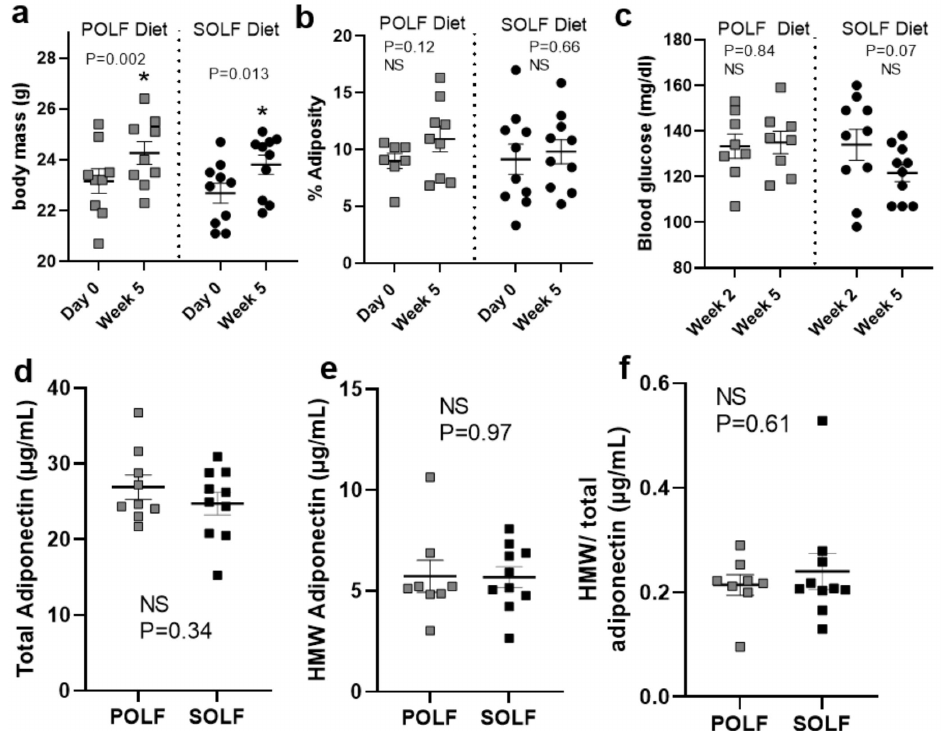
Figure 2. Physiological parameters of mice consuming POLF and SOLF diets for a 5-week period. ( a ) Change in body mass from Day 0 to Week 5, grouped by diet. ( b ) Percent adiposity as measured by EchoMRI from Day 0 to Week 5, grouped by diet. ( c ) Blood glucose measurements on Week 2 and Week 5, grouped by diet. ( a – c ) For each respective diet, a paired t -test was used to determine signifi- cant changes between measurements at the beginning and end of the study. ( d ) Total adiponectin and ( e ) high-molecular-weight adiponectin measured in plasma of mice after 5 weeks on the diet, as well as ( c ) the ratio of HMW/total adiponectin. ( a – c ) A paired t -test was used to determine changes between Day 0 and Week 5 within each diet group, while ANCOVA analysis was used to compare changes over time between groups and determine any significant differences between slopes over time. ( d – f ) Student’s t -tests were used to determine significant differences between diet groups at a single timepoint. An asterisk indicates p < 0.05 for ( a – c ) paired t -tests and ( d – f ) student’s t -tests, respectively. ‘NS’ indicates that p ≥ 0.05 and is non-significant for all analyses. While no significant differences in ANCOVA analysis and Student’s t -tests were determined. N =